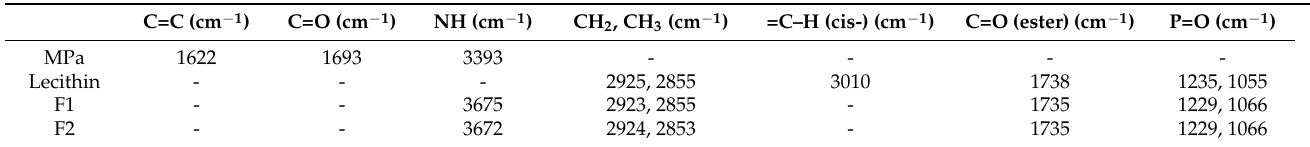
Table 4. Infrared absorption (cm − 1 ) of both C=C; C=O; and NH stretching in MPa, F1, and F2 and CH 2 , CH 3 ; =C-H (cis-); C=O (ester); and P=O stretching in lecithin, F1, and